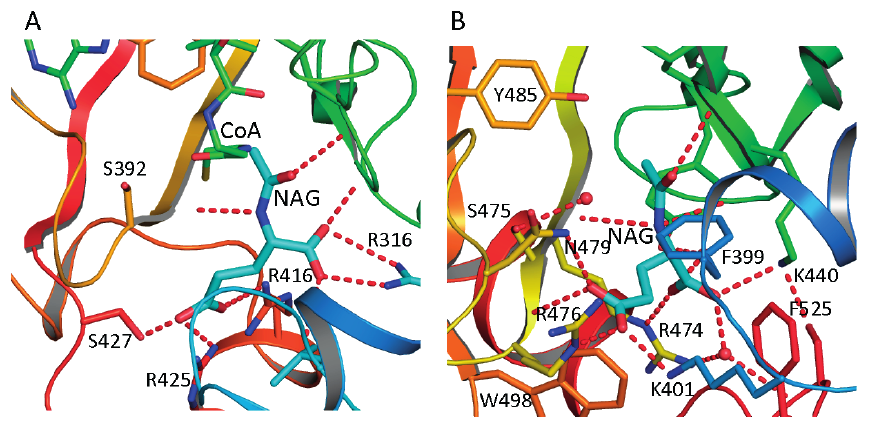
Figure 4. NAG binding site of ngNAGS ( A ) and hNAGS ( B ). The protein is shown in ribbon diagram. The bound NAG is shown as thick cyan sticks. The residues involved in binding NAG are shown as sticks. The hydrogen bonds are shown as red dashed